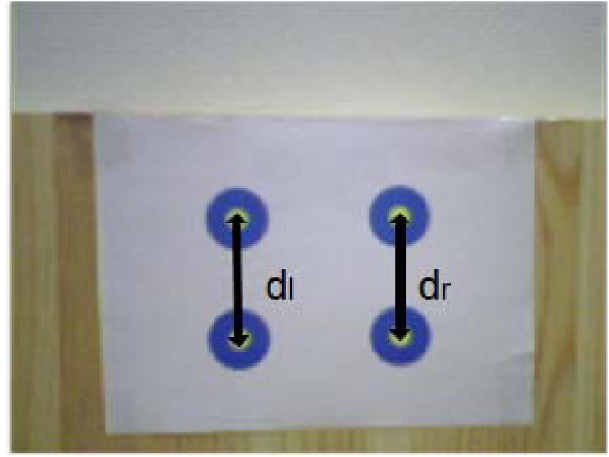
Figure 2. Landmark from the view of NAO